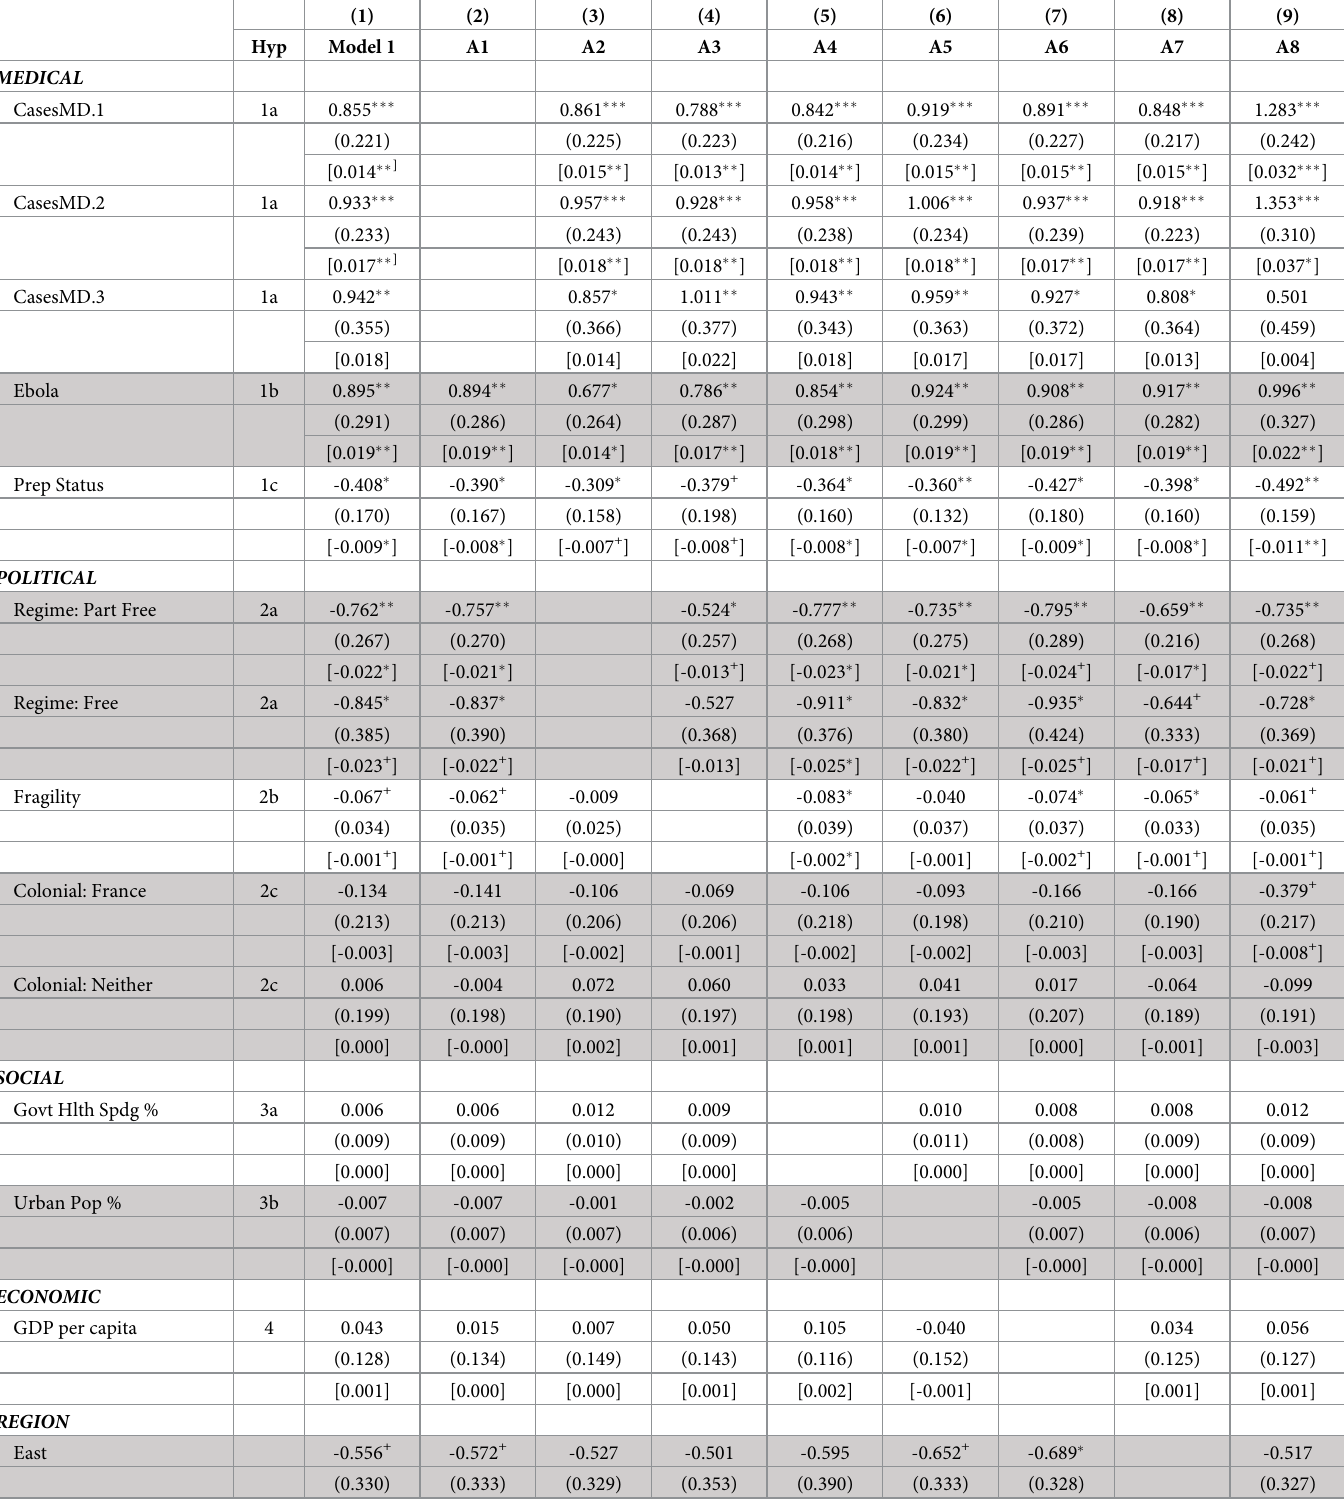
Table 4. Multivariate probit models with average marginal